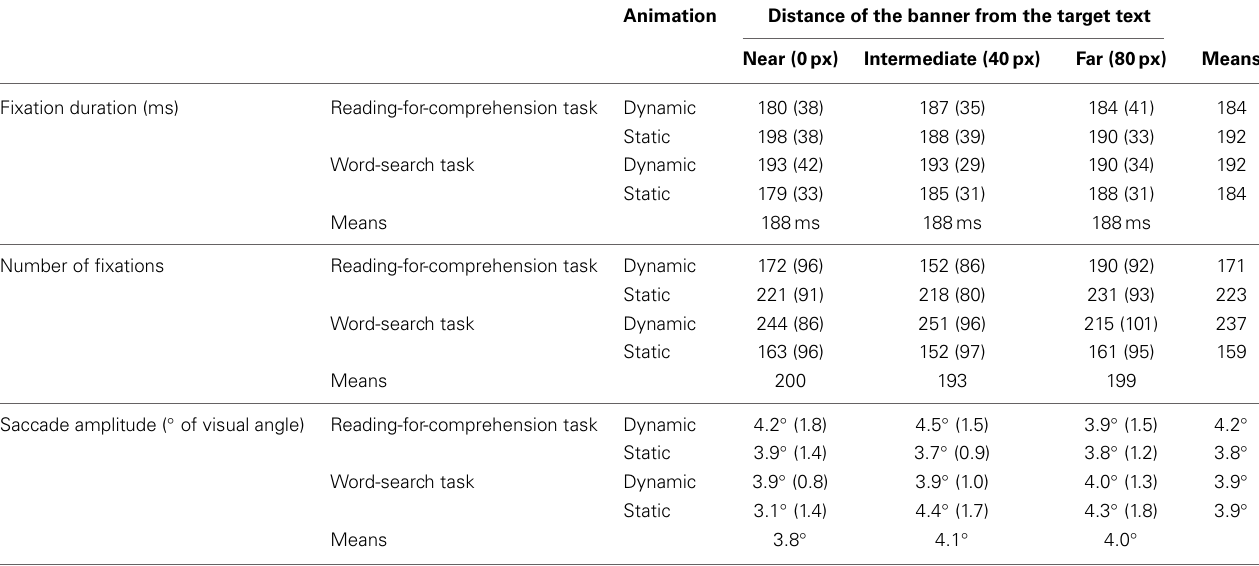
Table 1 | Average fixation durations (ms), average number of fixations and average saccade amplitude (degrees of visual angle) by task, animation, and banner location for all participants.